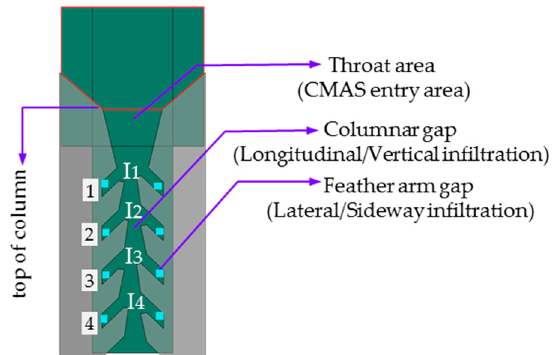
Figure 10. Defined sections at the columnar gap and void between feather arms for numerical data evaluation during infiltration kinetics study